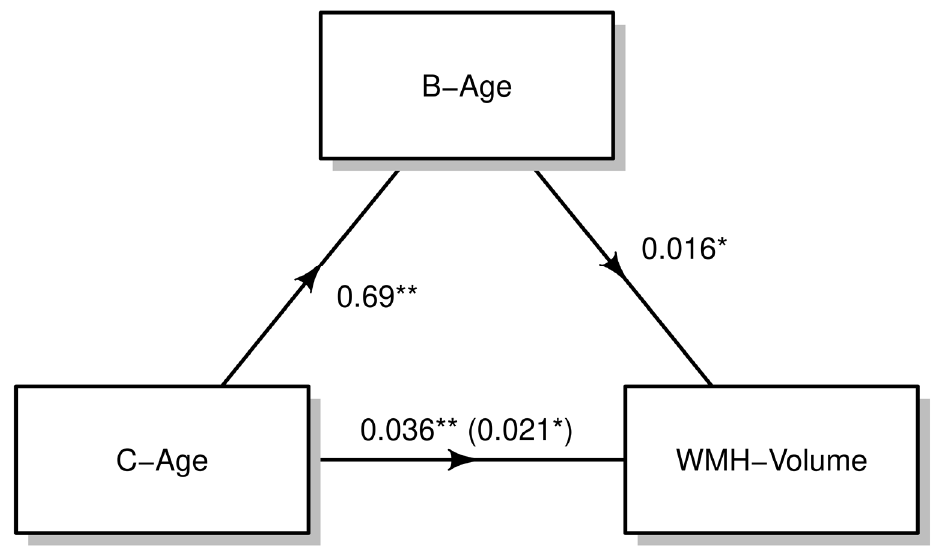
Figure 3. Causal mediation analysis. After bootstrap resampling, C-age showed a significant effect on B-age ( β = 0.7), which was subsequently related to WMH-volume ( β = 0.016). Mediation analysis revealed a significant partial mediation on the effect of C-age on WMH via B-age ( β -coefficient reduction from 0.036 to 0.021). These effects are adjusted for those variables that entered in the forward stepwise regression model (see Table 3). * p -value < 0.05; ** p -value < 0.01.